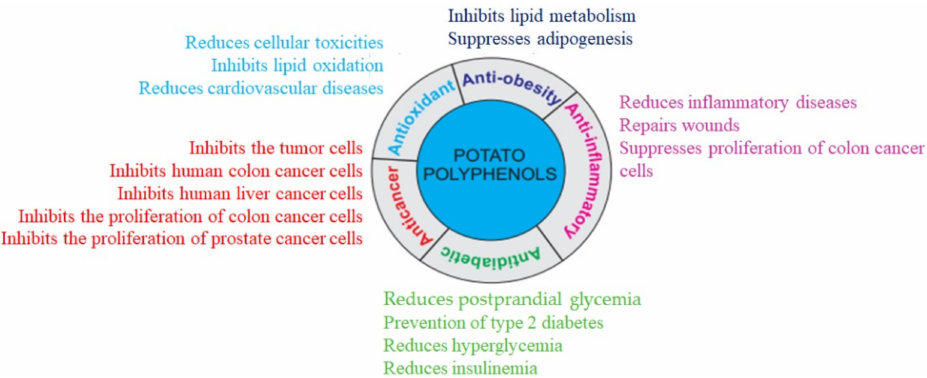
Figure 3. Polyphenols in potatoes represent various beneficial health